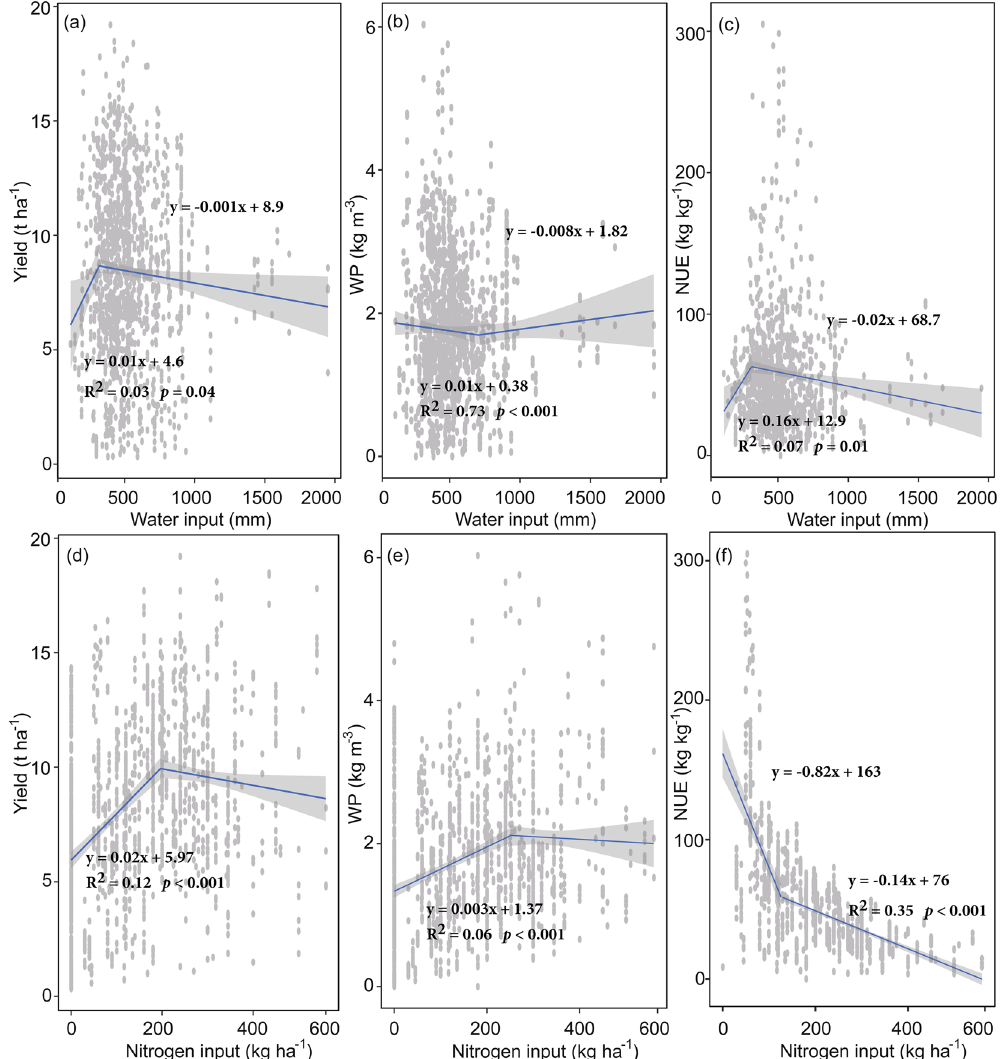
Figure 1. Relationships between total water input and maize ( a ) yield, ( b ) water productivity (WP), and ( c ) nitrogen use efficiency (NUE), and relationships between total nitrogen input and ( d ) yield, ( e ) water productivity (WP), and f) nitrogen use efficiency (NUE). Data points were split into two parts according to a breakpoint. The breakpoint between the two lines of water input is 314.4, 708.9, and 311 mm for yield, WP, and NUE, respectively. The breakpoint between the two lines of nitrogen is 249.9, 127.5, and 196 kg ha − 1 for yield, WP, and NUE, respectively. Linear regressions were made for the sub-datasets accordingly, using the ordinary least square method. Grey areas indicate 95% confidence intervals. Note the different scales among the